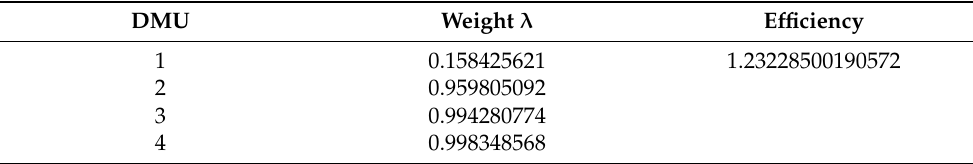
Table 6. Solution of non-parametric data envelopment analysis (DEA) method of measuring eco- efficiency. DMU, decision-making unit. DMU Weight λ